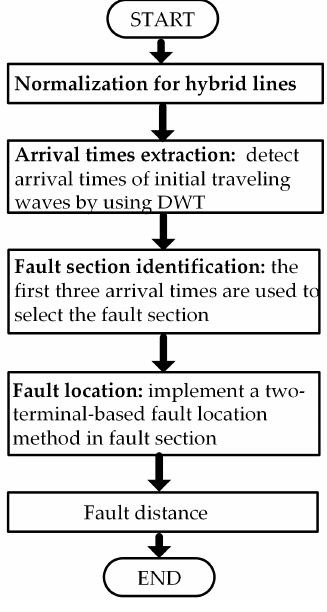
Figure 4. Overall flowchart of the proposed method.